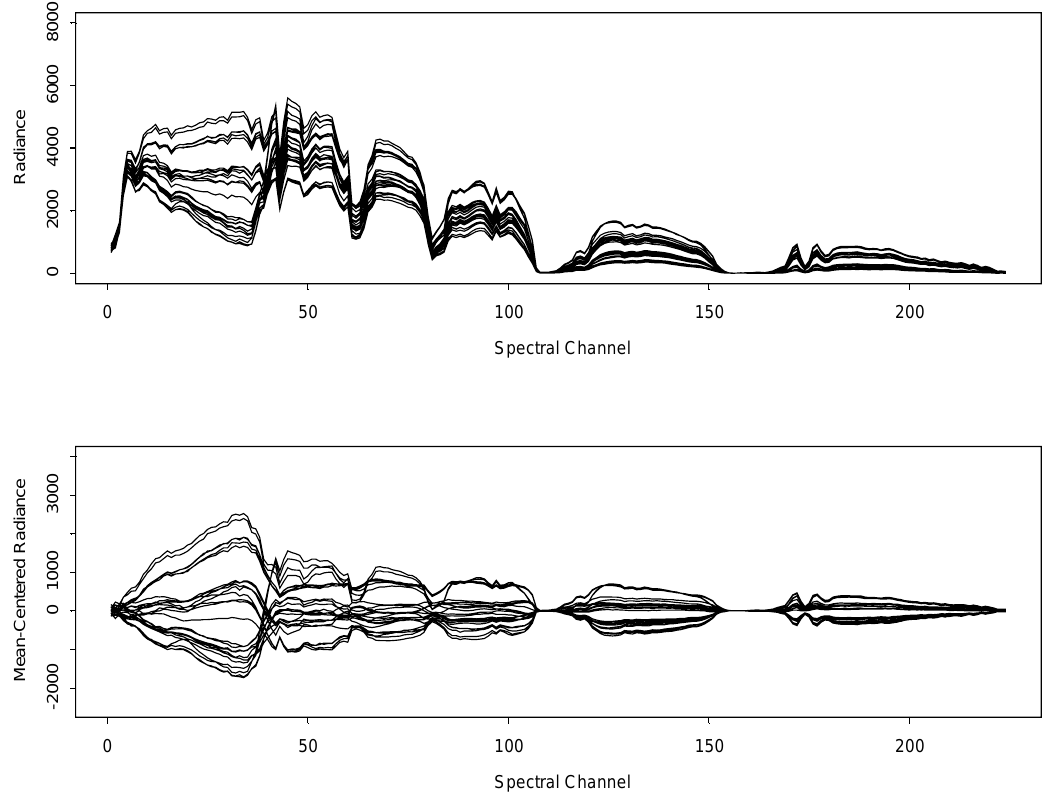
Figure 2 . (top) Example radiance from selected pixels from Scene A.; (bottom) Example mean- centered radiance from selected pixels from Scene